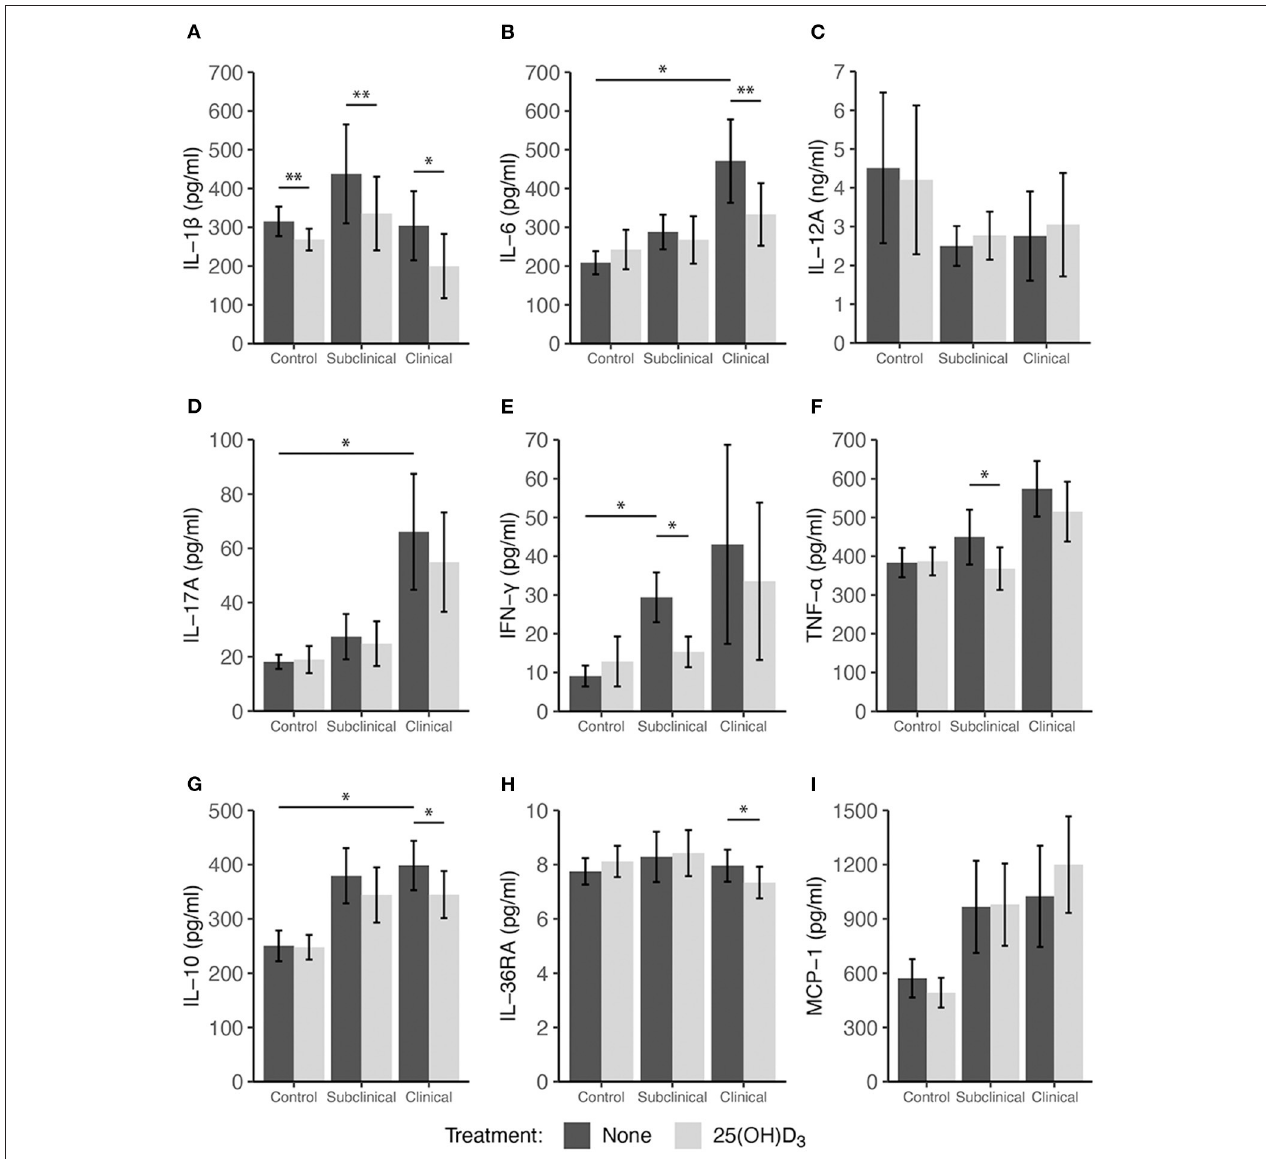
FIGURE 3 | Secretion of cytokines by PBMCs isolated from naturally infected dairy cattle (subclinical n = 8, clinical n = 8) or non-infected controls ( n = 8). Peripheral blood mononuclear cells were cultured 24h with whole cell MAP sonicate (MPS) ± 100ng/ml 25(OH)D 3 . Cell culture supernatants were incubated overnight with cytokine specific magnetic beads for (A) IL-1 β , (B) IL-6, (D) IL-17A, (E) IFN- γ , (F) TNF- α , (G) IL-10, (H) IL-36RA, and (I) MCP-1 supplied in the Milliplex bovine multiplex assay. Fluorescence was measured using the Luminex MAGPIX xMAP instrument and cytokine concentrations were determined by standard curve. Standard ELISA was used to measure (C) IL-12A concentrations. Data are presented as the mean ± SE and significance levels are as follows: * < 0.05, ** < 0.01, *** < 0.001.